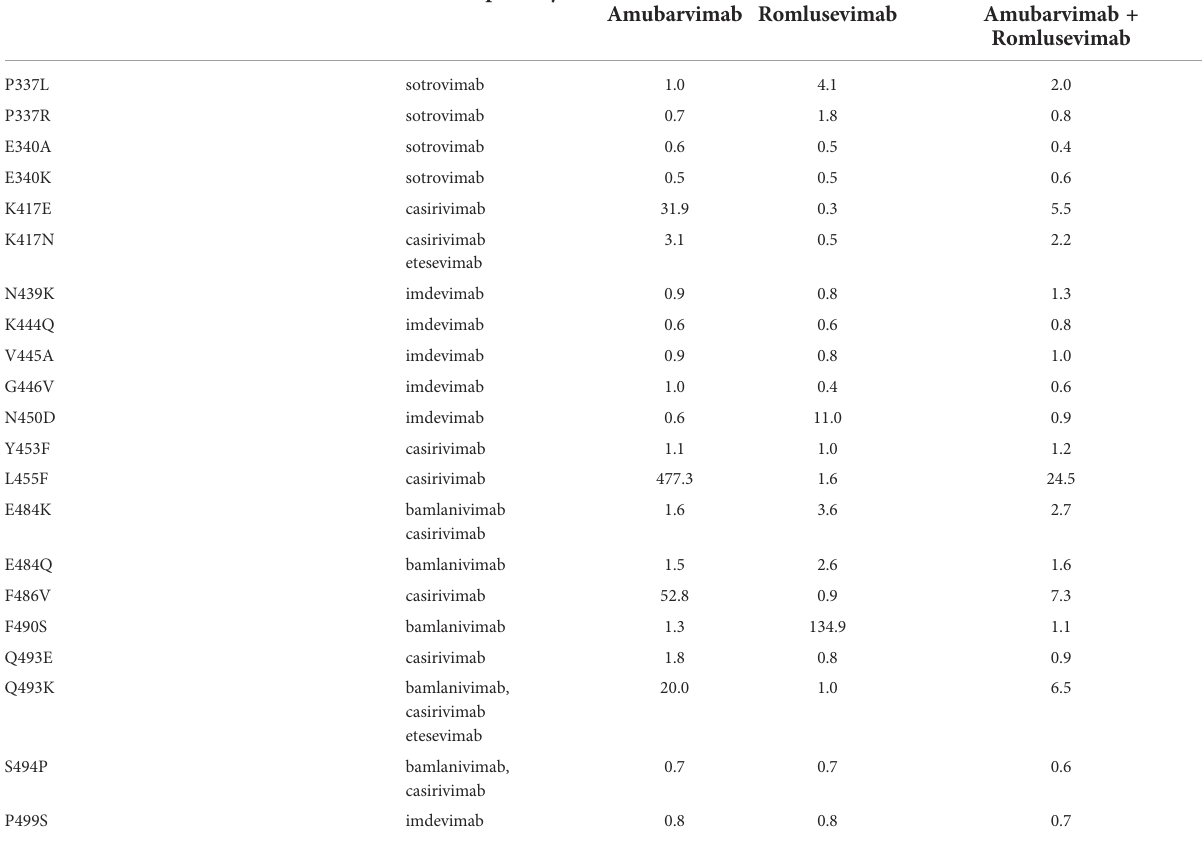
TABLE 2 Neutralization of amubarvimab and romlusevimab against variant pseudoviruses conferring reduced susceptibility to authorized mAbs. Amino acid substitution in tested variant mAb with reduced